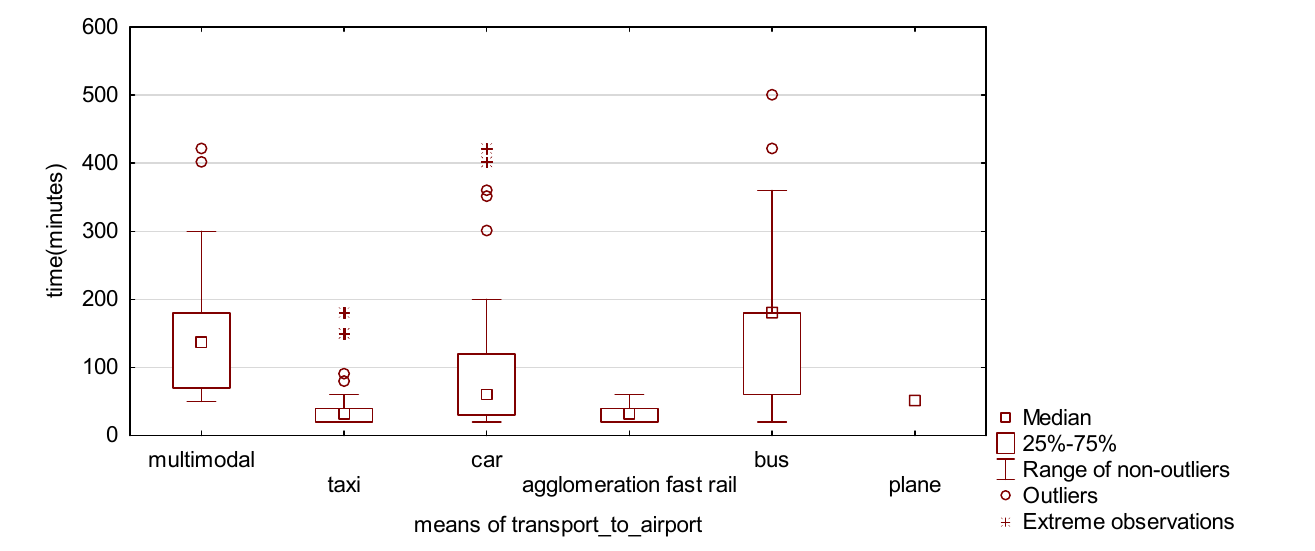
Figure 3. Box-whisker test for travel time according to the chosen means of transport for travelling to the airport.